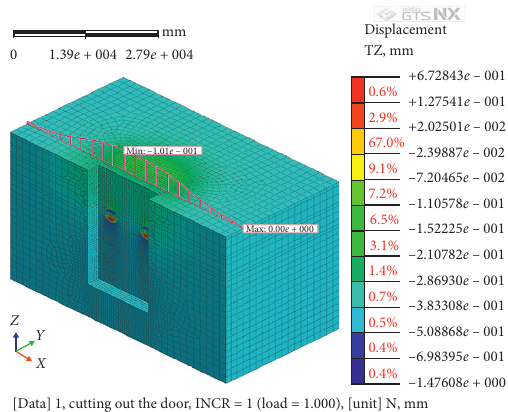
Figure 6: Surface subsidence diagram at 3m of longitudinal reinforcement length.